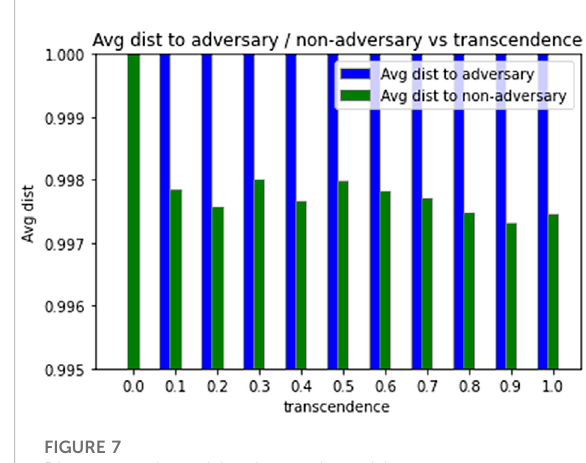
FIGURE 6 Average value of gamma at equilibrium given initial value of gamma with standard error bars.